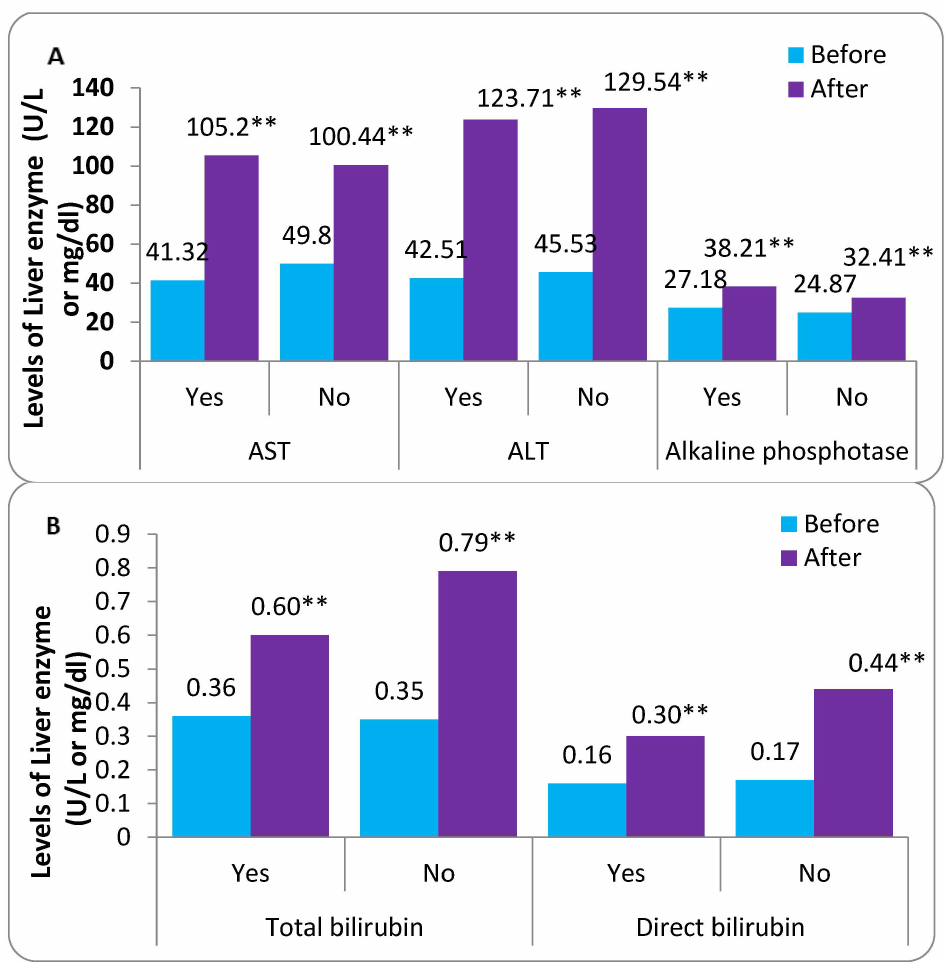
Figure 5. Comparison between Patients who were treated with FVP according to Chronic Disease ( A , B ). ** means significant difference using paired t -test at p < 0.05. 3.10. Comparison between Patients Treated and Untreated with FVP Based on Chronic Disease The results in Table 6 show the differences in the different parameters (liver enzymes) between the cases with chronic diseases and healthy case subjects and those who did not receive FVP before and after treatment. Statistical analysis showed no statistically significant differences for all claims under study for all parameters (AST, ALT, alkaline phosphatase, total bilirubin, and direct bilirubin) in patients with chronic diseases and healthy subjects for all parameters except the patients in AST before treatment. On the other hand, statistical analysis showed a statistically significant difference between all parameters before and after treatment using the paired t -test at p <